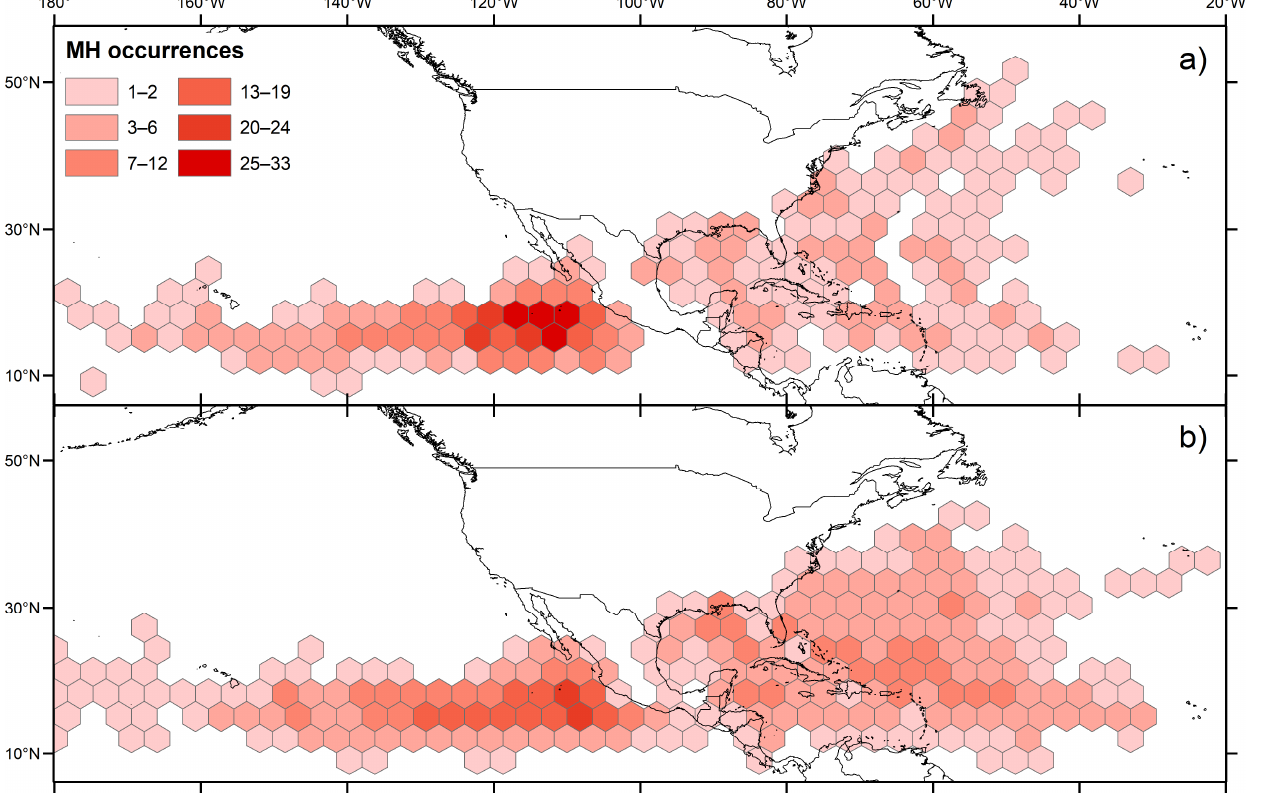
Figure 2. Occurrence of MHs in the NEP and NA basins for: ( a ) 1970 to 1995; and ( b ) 1996 to 2021 (hexagons are 3.5°).